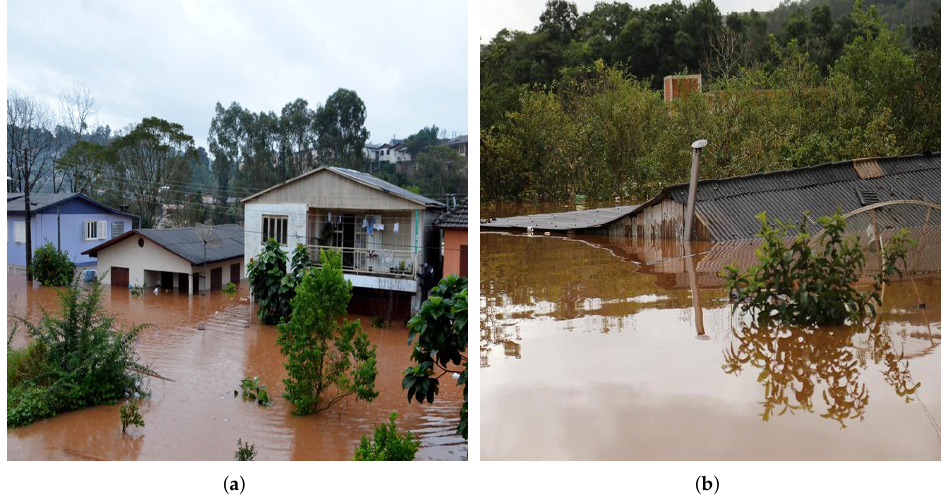
Figure 3. Municipalities affected by extreme rains. ( a ) flooding in the municipality of Iraí located north of Rio Grande do Sul state; ( b ) flooding in the municipality of Chapecó located west of Santa